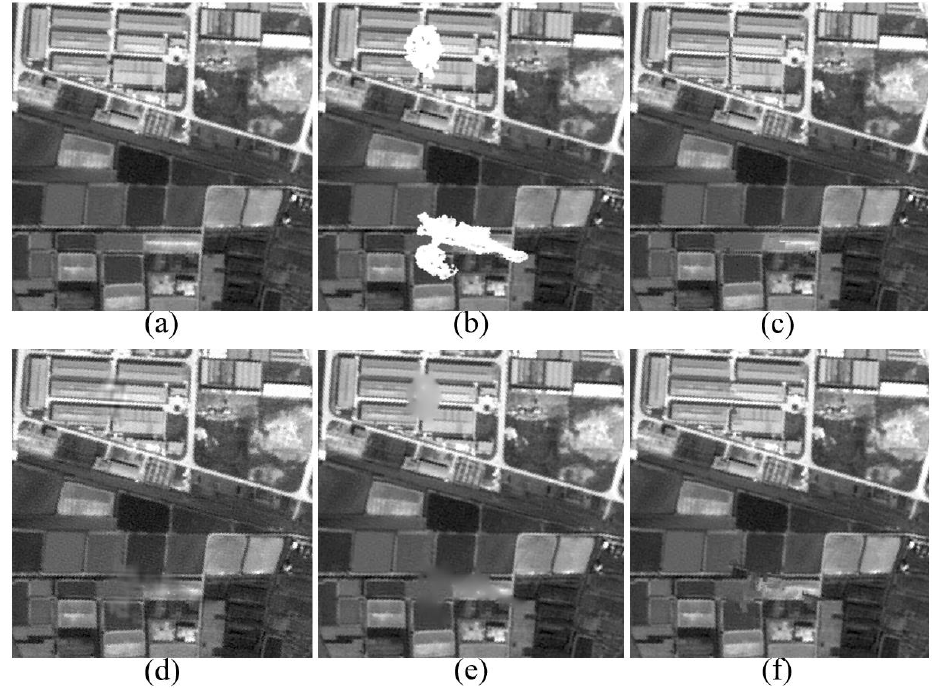
Table 2. Comparisons of Statistical Indices on Aerial and SPOT5 Imagery.